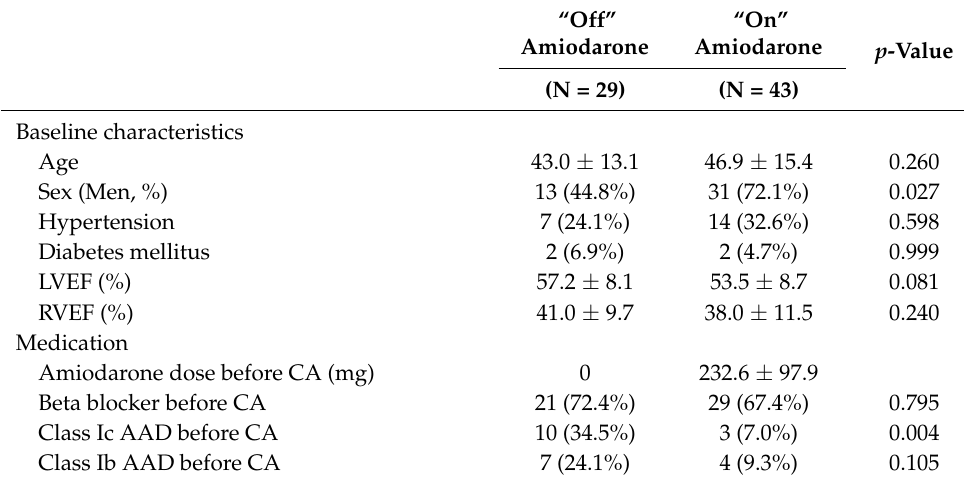
Table 1. Comparison of baseline characteristics between patients with ARVC “On” and “Off” amio- darone before